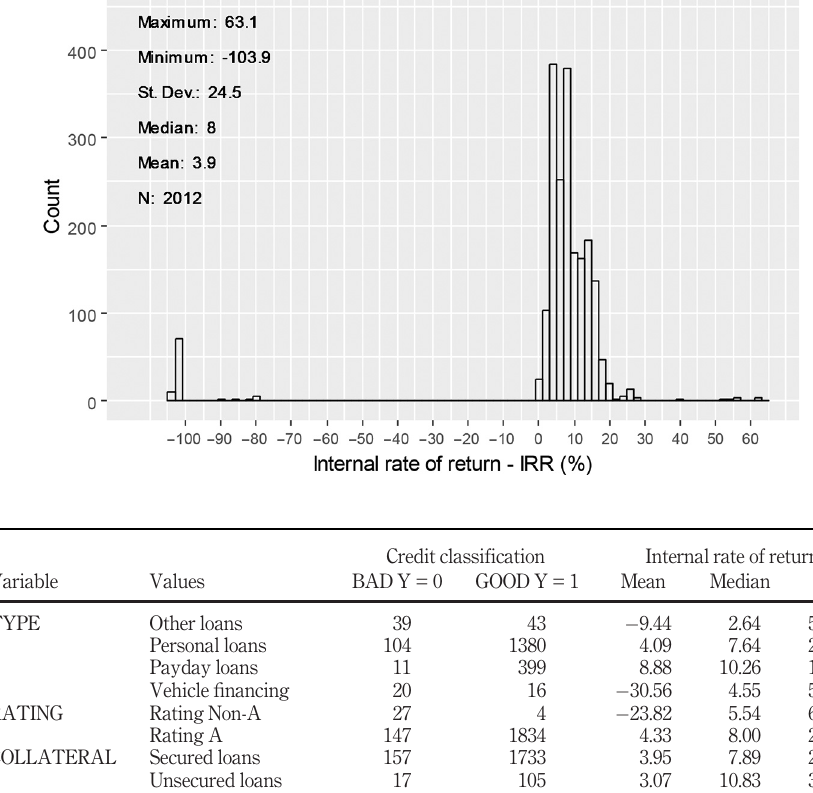
Table III. Descriptive statistics of discrete